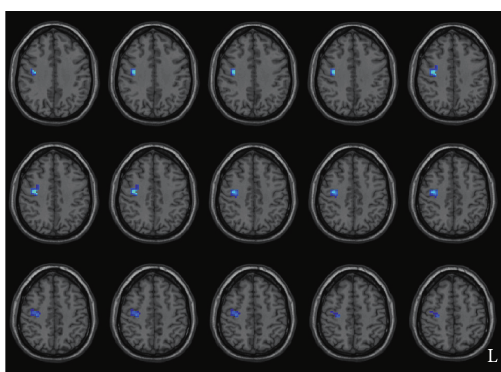
Figure 3: Decreased ReHo in the right precentral gyrus and right middle frontal gyrus. L indicates the left